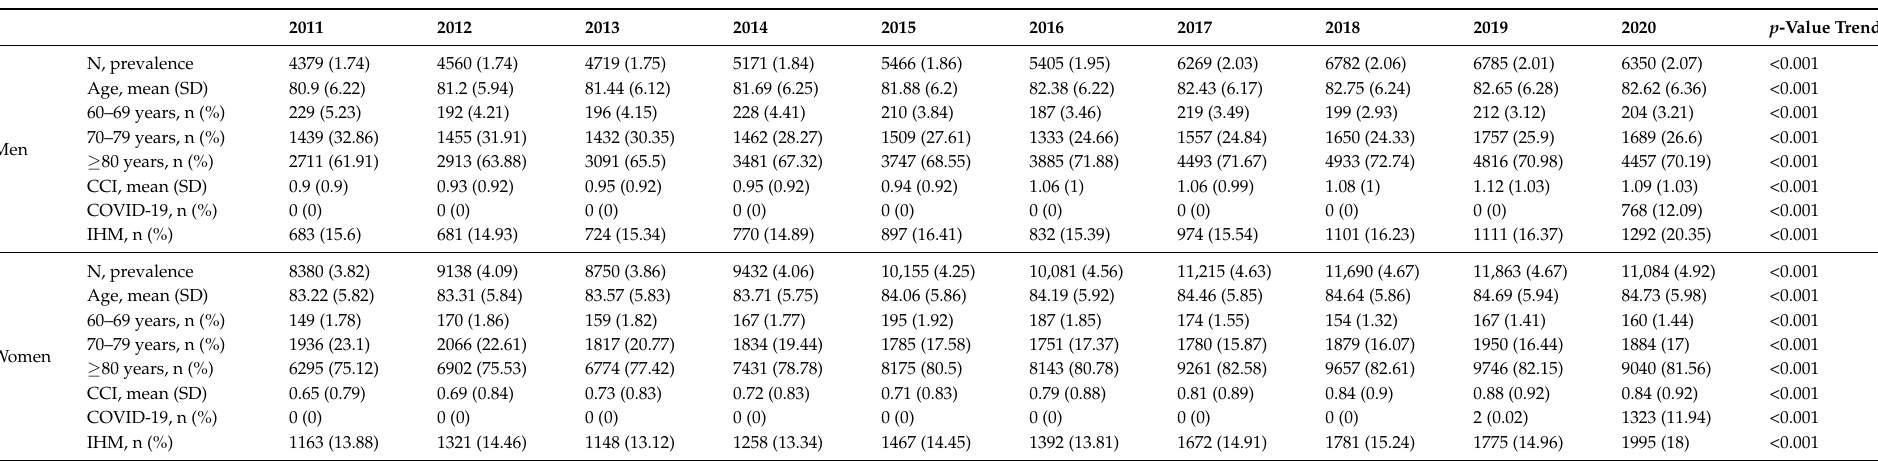
Table 3. Prevalence of Alzheimer disease. Distribution by age and clinical characteristics and in-hospital outcomes among men and women hospitalized with type 2 diabetes in Spain,